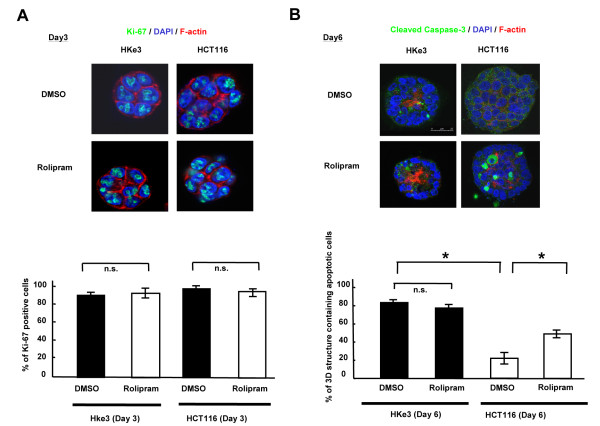
Induction of luminal apoptosis by rolipram in HCT116 cells grown in 3 DC.(A) The signals for Ki-67 in HCT116 and HKe3 cells treated with DMSO alone or rolipram at day 3 in 3 DC. Ki-67, green; F-actin, red; nuclear DNA (DAPI), blue. Scale bar = 50 μm (upper panels). The ratio of Ki-67-positive cells in 3-D structures (lower panel). Black bar, 3-D structures treated with DMSO alone; white bar, 3-D structures treated with rolipram. n.s., not significant. (B) The signals for cleaved caspase-3 in HCT116 and HKe3 cells treated with DMSO alone or rolipram at day 6 in 3 DC (upper panels). F-actin, red; DAPI, blue; cleaved caspase-3, green. Scale bar = 50 μm. The ratio of the 3-D structures containing apoptotic cells (lower panel). Black bar, 3-D structures treated with DMSO alone; white bar, 3-D structures treated with rolipram. *, P < 0.001; n.s., not significant.